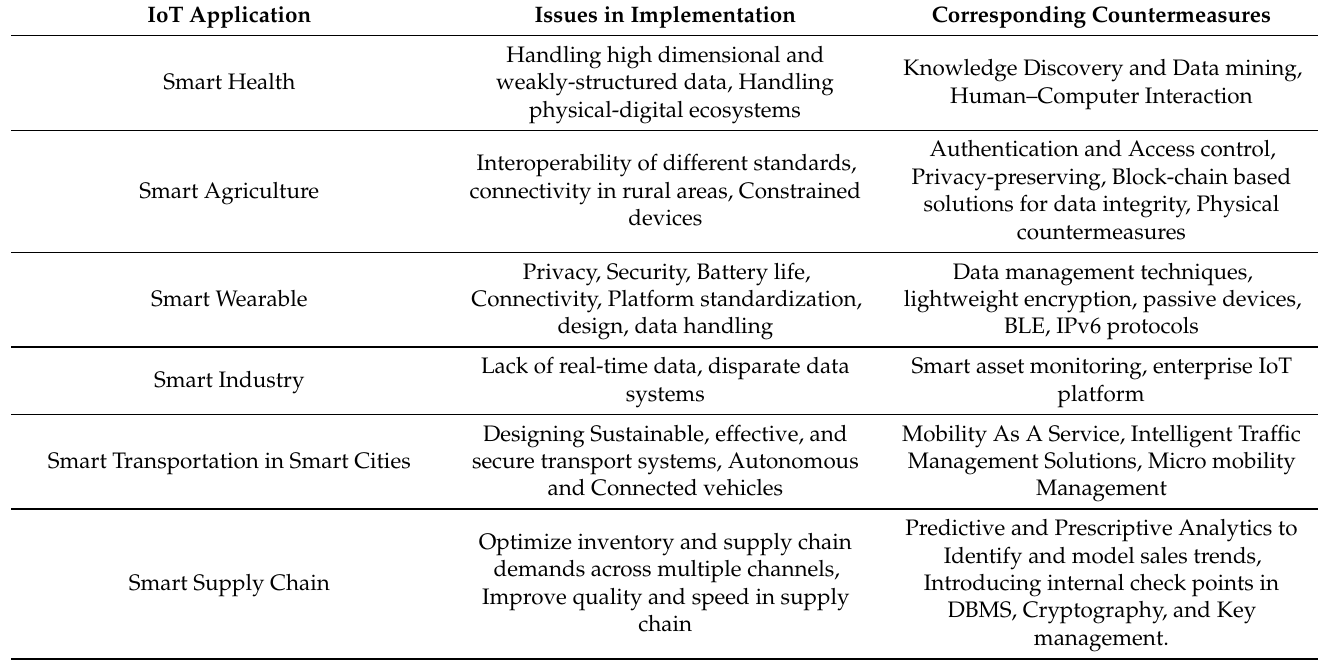
Table 3. Issues and corresponding solutions of IoT